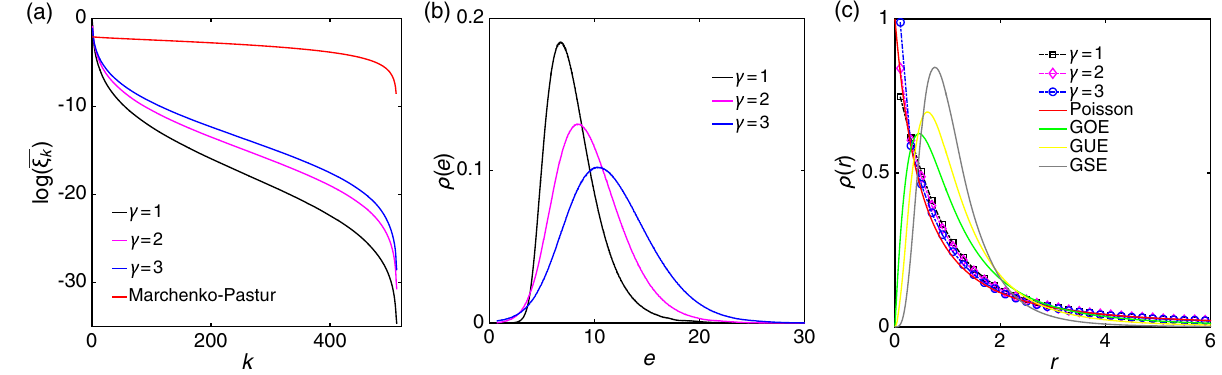
FIG. 5. Entanglement spectrum and level statistics for neural-network states with random weight parameters. Here, the lattice size is chosen to be L ¼ 20 , and we have used 10 4 random samples. The random parameters are drawn from the same distribution as specified in Fig. 4. (a) Averaged entanglement spectrum with different γ . Here, ξ k denotes the k th eigenvalue of ρ A (the eigenvalues are arranged in descending order). The red line denotes the spectrum of a completely random state (derived from a Marchenko-Pastur distribution). It is evident that the entanglement spectra of the restricted-Boltzmann-machine states with random parameters are completely distinct from the Marchenko-Pastur distribution, indicating that their corresponding entanglement Hamiltonians are very different from Wishart matrices. (b) Density of states for the entanglement Hamiltonians. Here, e denotes the eigenspectrum of H . When increasing γ , the ent distribution of the eigenvalues broadens, and the peak shifts rightwards. (c) Distributions of the ratios of consecutive spacings for the entanglement spectrum. These distributions follow a Poisson law and differ significantly from the predictions of GOE, GUE, or